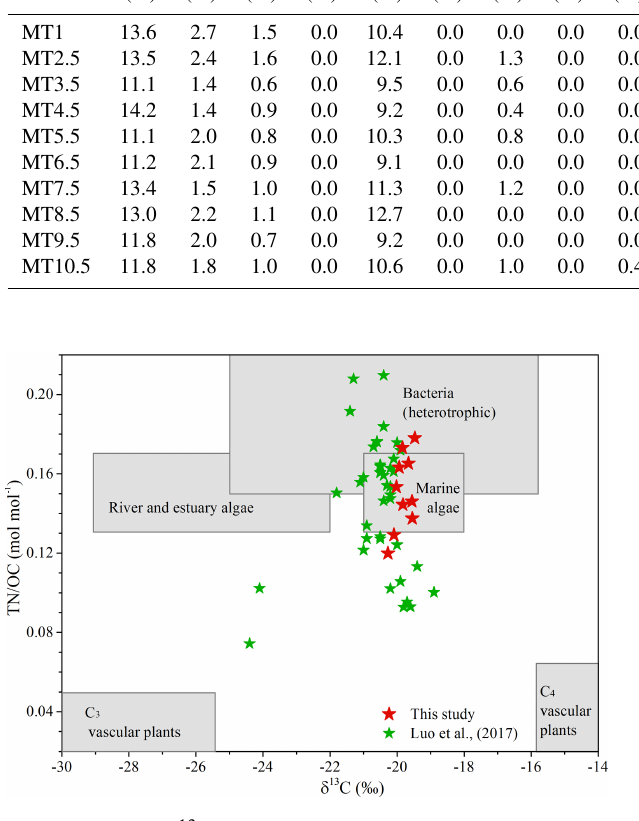
Figure 4. Plot of δ 13 C OC versus TN / OC for core sediments from the Mariana Trench (MT). Included in this graph are different com- positional ranges of C 3 vascular plants, C 4 vascular plants, bacteria, river and estuary phytoplankton, and marine phytoplankton sources. The compositional range of different end members was cited from Goñi et al. (2006) and Hu et al. (2016). The red stars and green stars denote data from this study and Luo et al. (2017),